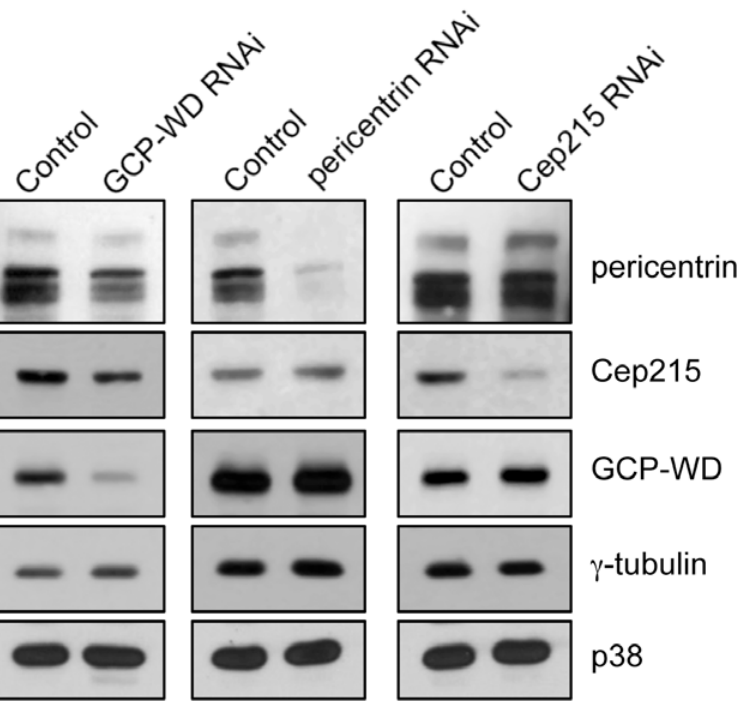
Figure 5. RNAi-mediated depletion of GCP-WD, pericentrin and Cep215, respectively, does not affect the levels of other centrosome proteins. After RNAi-mediated depletion of the indicated proteins in Hela cells, whole cell extracts were analyzed by westernblotting using specific antibodies as indicated. The p38 protein was used as a loading control.